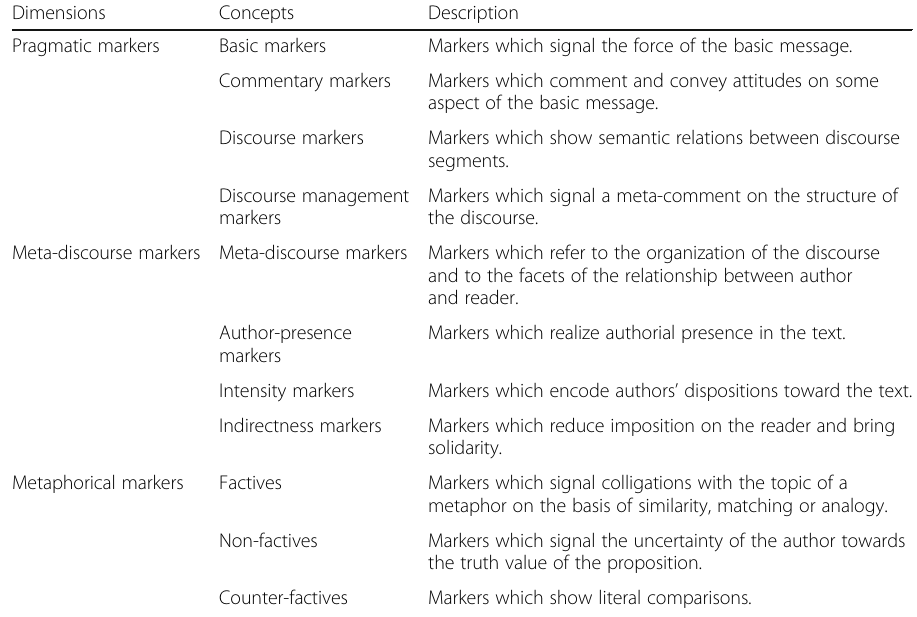
Table 7 A Meta-synthesized Model of RMs Competence in Writing EAP RAs